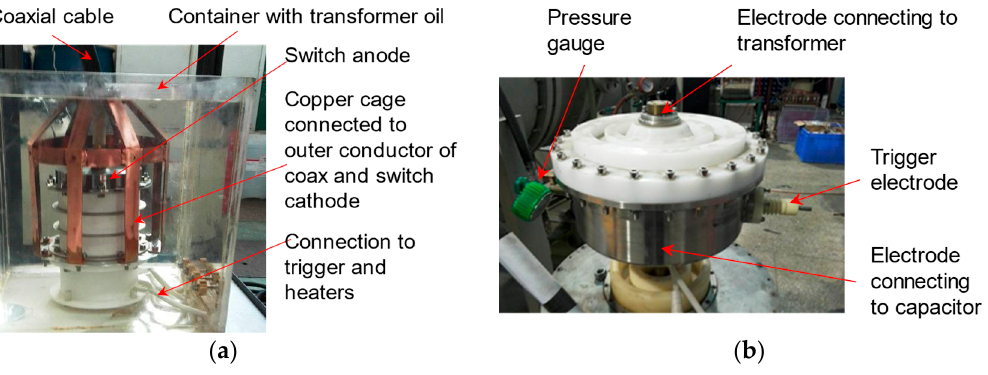
Figure 9. ( a ) Pseudo-spark switch and ( b ) trigatron switch.